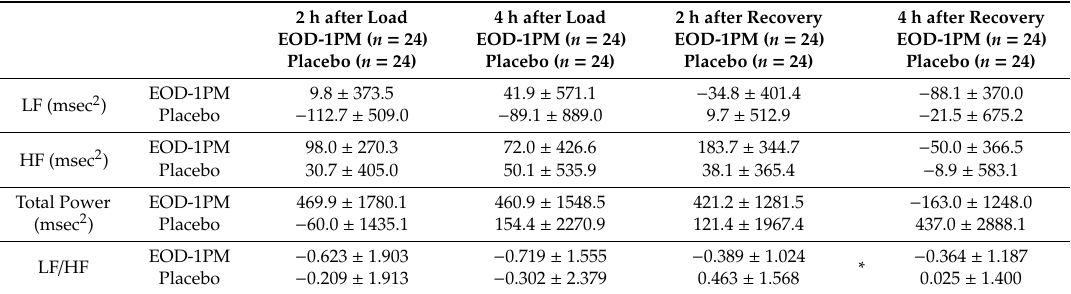
Table 6. Evaluation of autonomic nerve function: changes from the time of facility arrival (di ff erence in pre- and